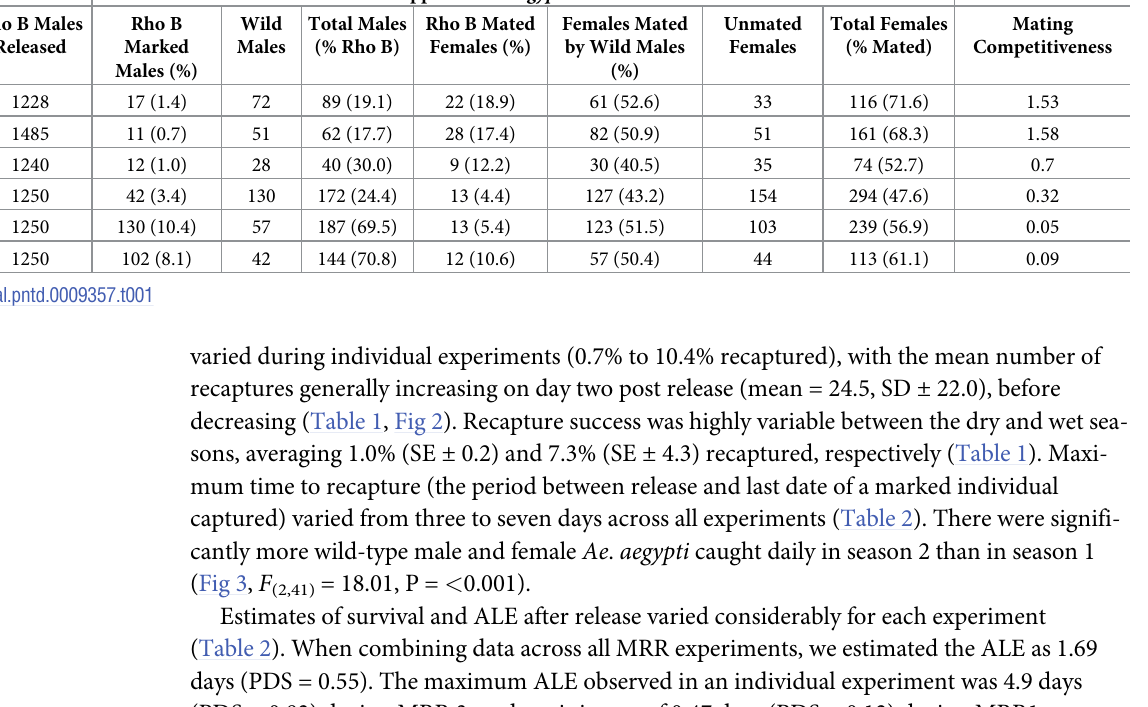
Trapped Aedes aegypti individuals